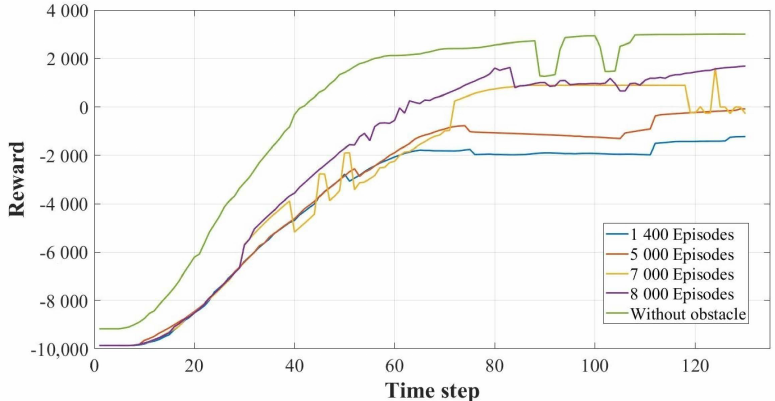
Figure 10. Reward for each number of training episode for straight motion